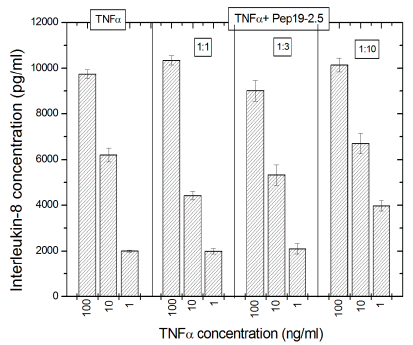
Figure 11. Influence of Pep19-2.5 on tumor necrosis factor α -induced stimulation of human mononu- clear cells (10 6 /mL) to secret interleukin-8. Mean values and standard deviations due to the determi- nation of TNF α in duplicate.